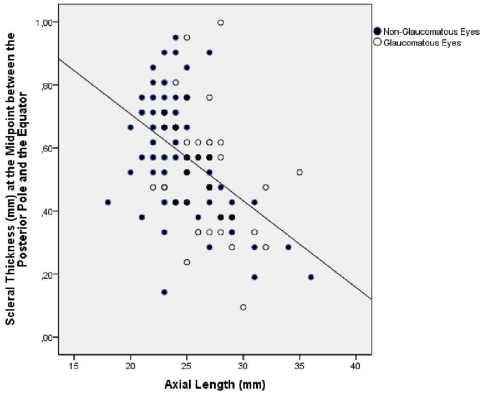
Scatterplot showing the correlation between axial length and the scleral thickness measured at the midpoint between the posterior pole and the equator in human globes (correlation coefficient = 0.48; P<0.001).Blue Circles The association was not statistically significant (P = 0.23), if only non-axially elongated eyes (axial length ≤26 mm) were included.